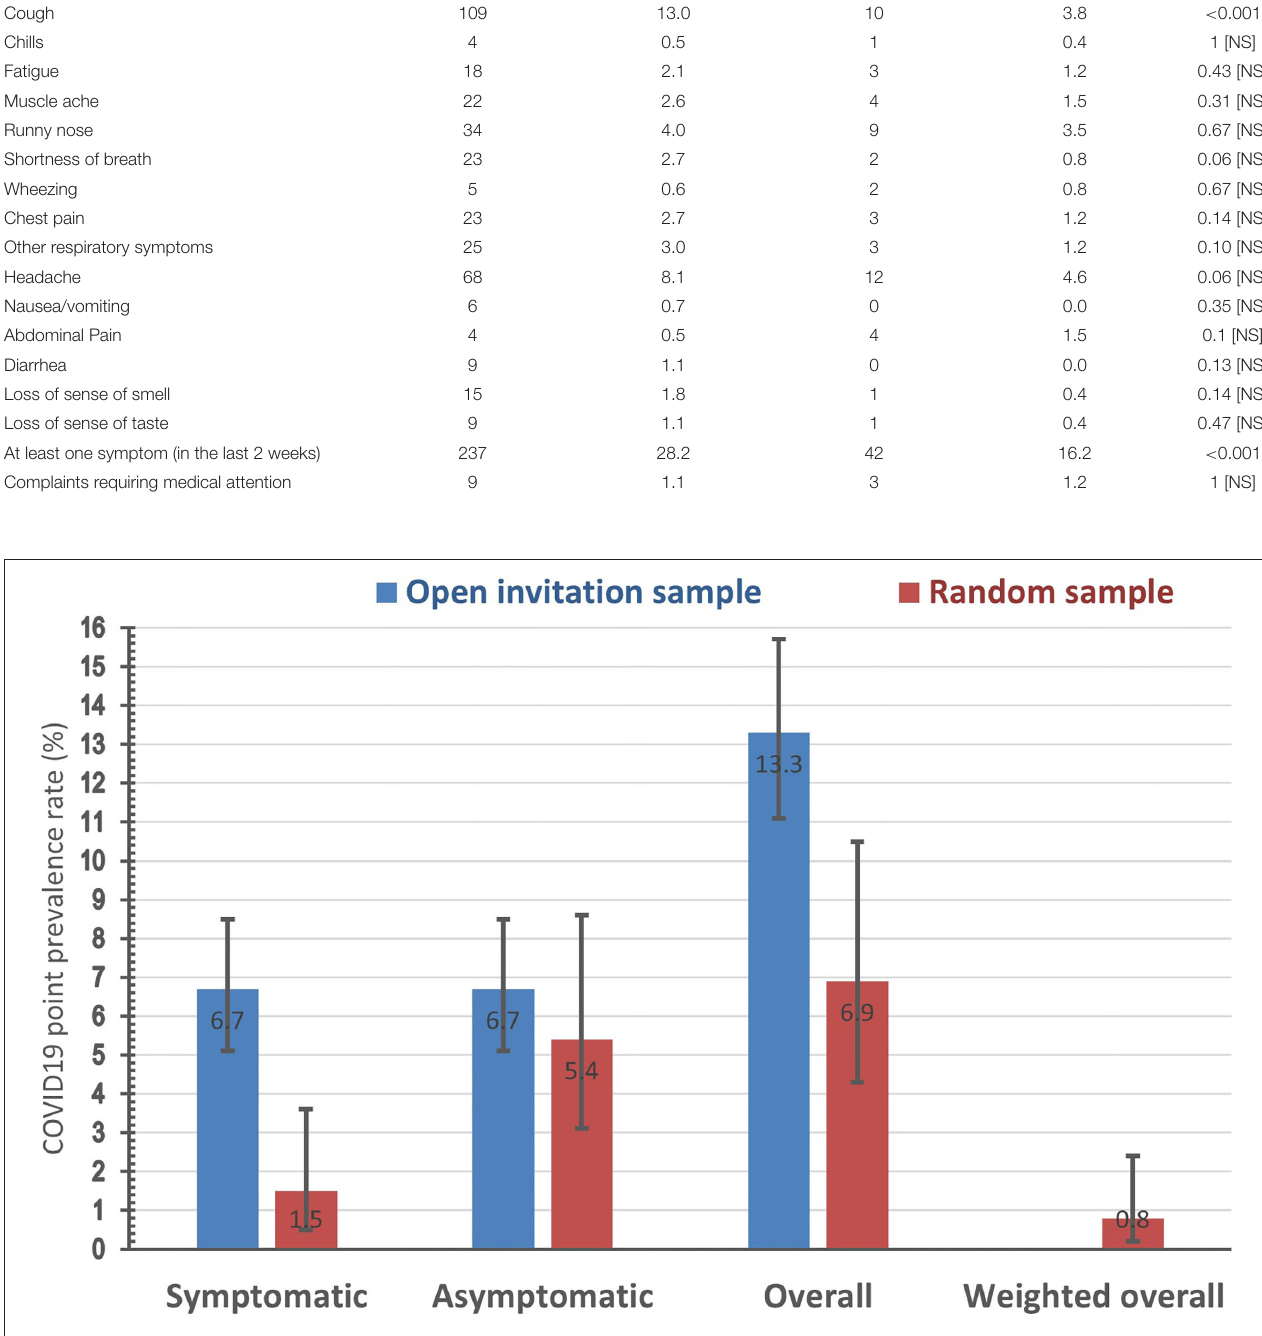
Frontiers in Public Health |